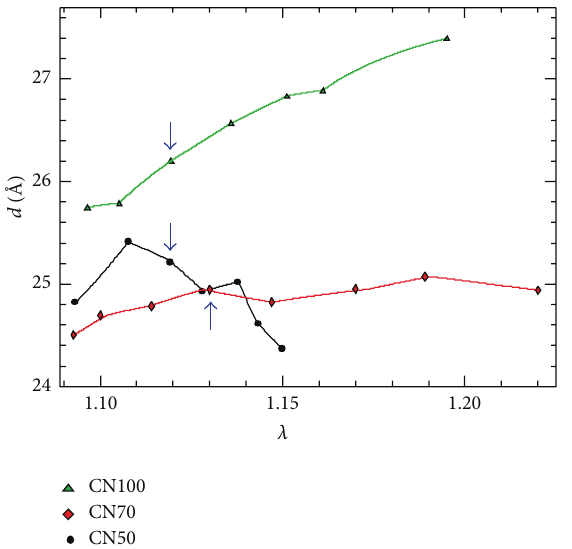
Figure 12: 𝛿𝜆 versus 𝑇 below 𝑇 ∗ . The dotted lines are best fits to /𝑘 𝑇) , where 𝑎 ( 𝑇 ∗ − 𝑇 ) corresponds to the 𝛿𝜆 = 𝑎 ( 𝑇 ∗ − 𝑇 ) exp (𝐸 0 𝑏 number of defects and/or smectic domains and 𝐸 0 is the dislocation activation energy.